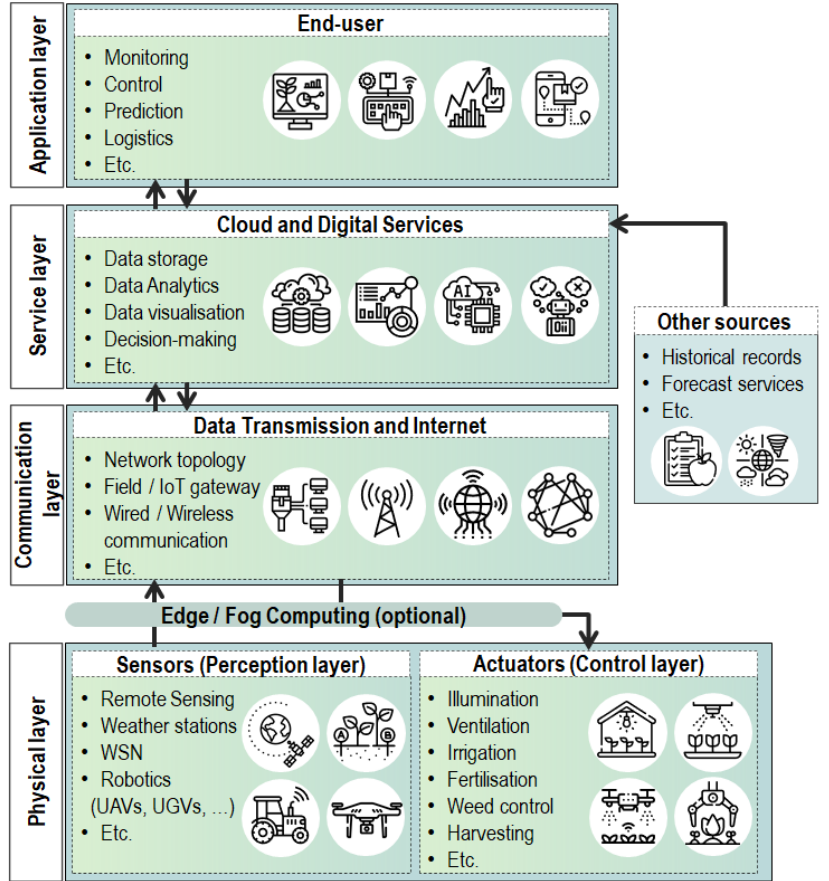
Figure 9. Conceptual cloud-based IoT architecture for Agriculture 4.0, consisting on four layers: physical layer (where data are collected at the perception layer), communication layer (where an adequate network allows the data communication between layers), service layer (for data storage, processing and analysis) and application layer (for access of agricultural information and control